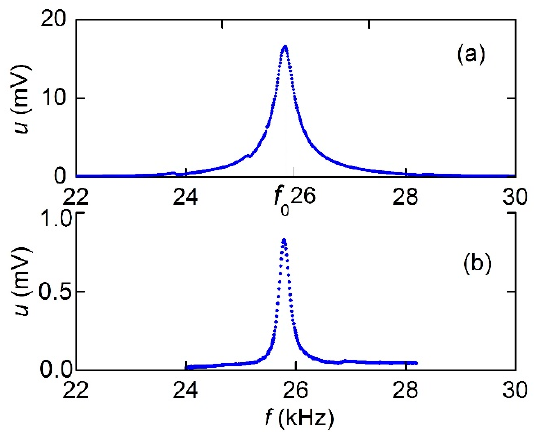
Figure 5. Dependence of the magnetoelectric (ME) voltage u on the excitation frequency f in the MFC-PZT structure with a period T 1 = 250 µ m and the magnetic field directed ( a ) parallel and ( b ) perpendicular to Ni-wires.